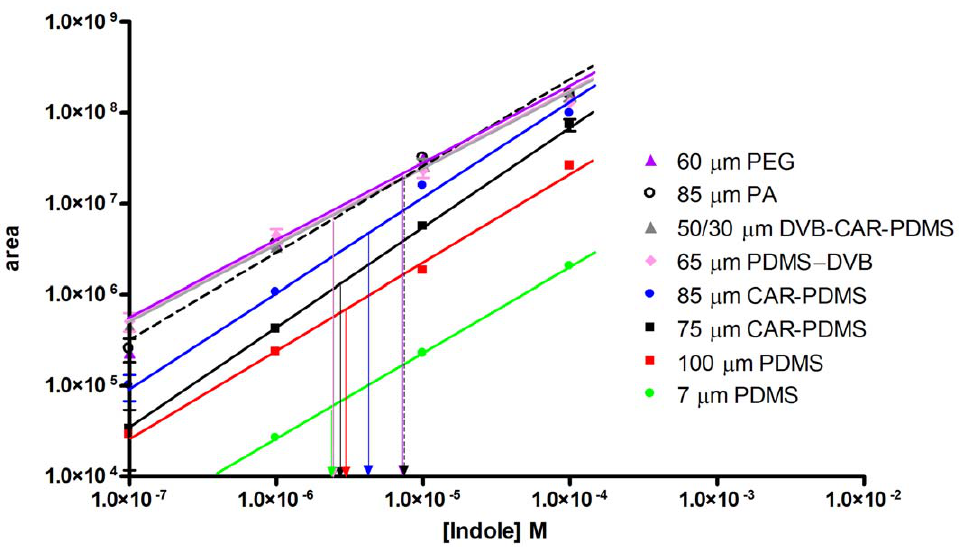
Figure 4. Indole standard curves generated by headspace SPME. Chromatographic peak area is plotted as a function of indole concentration, illustrating fiber-dependent differences in the partition coefficient for indole. Peak areas taken from Fig. 3 were used to determine the concentration of indole extracted using each fiber (arrows).